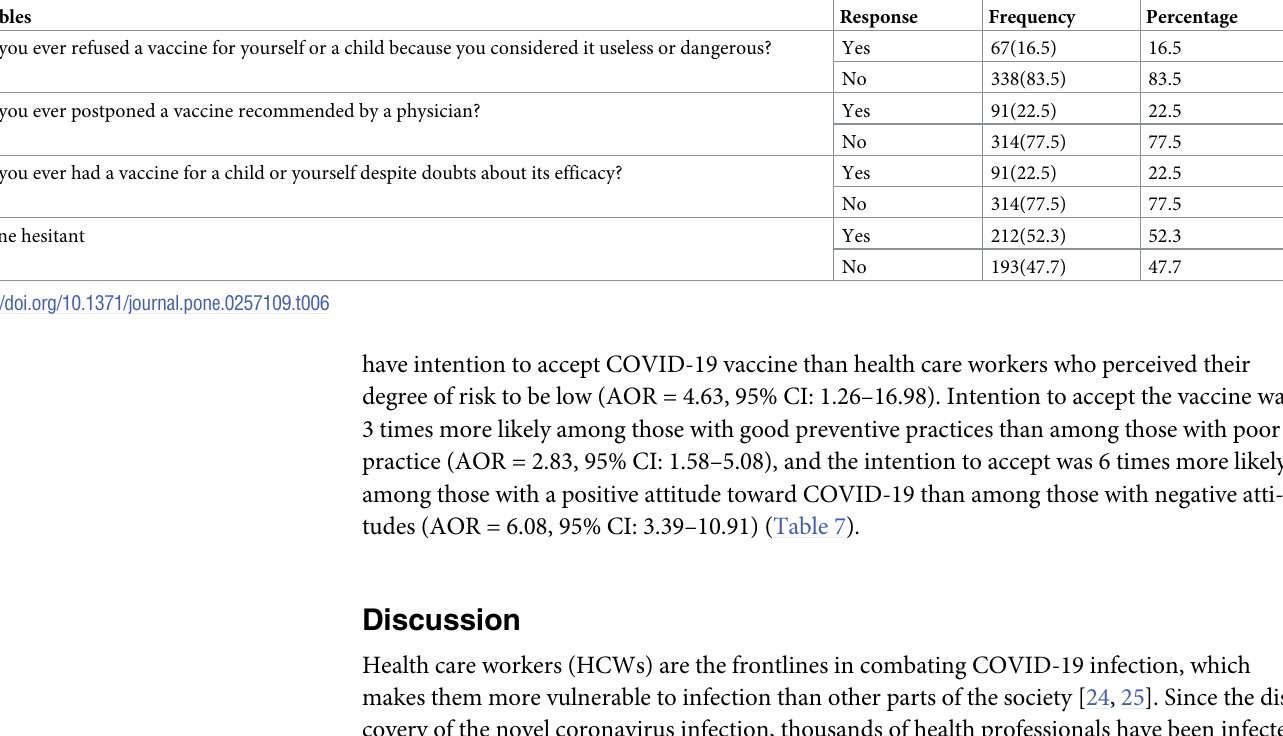
Table 6. Vaccine hesitancy among HCWs working at hospitals of southwestern Ethiopia, 2021 (n = 405).